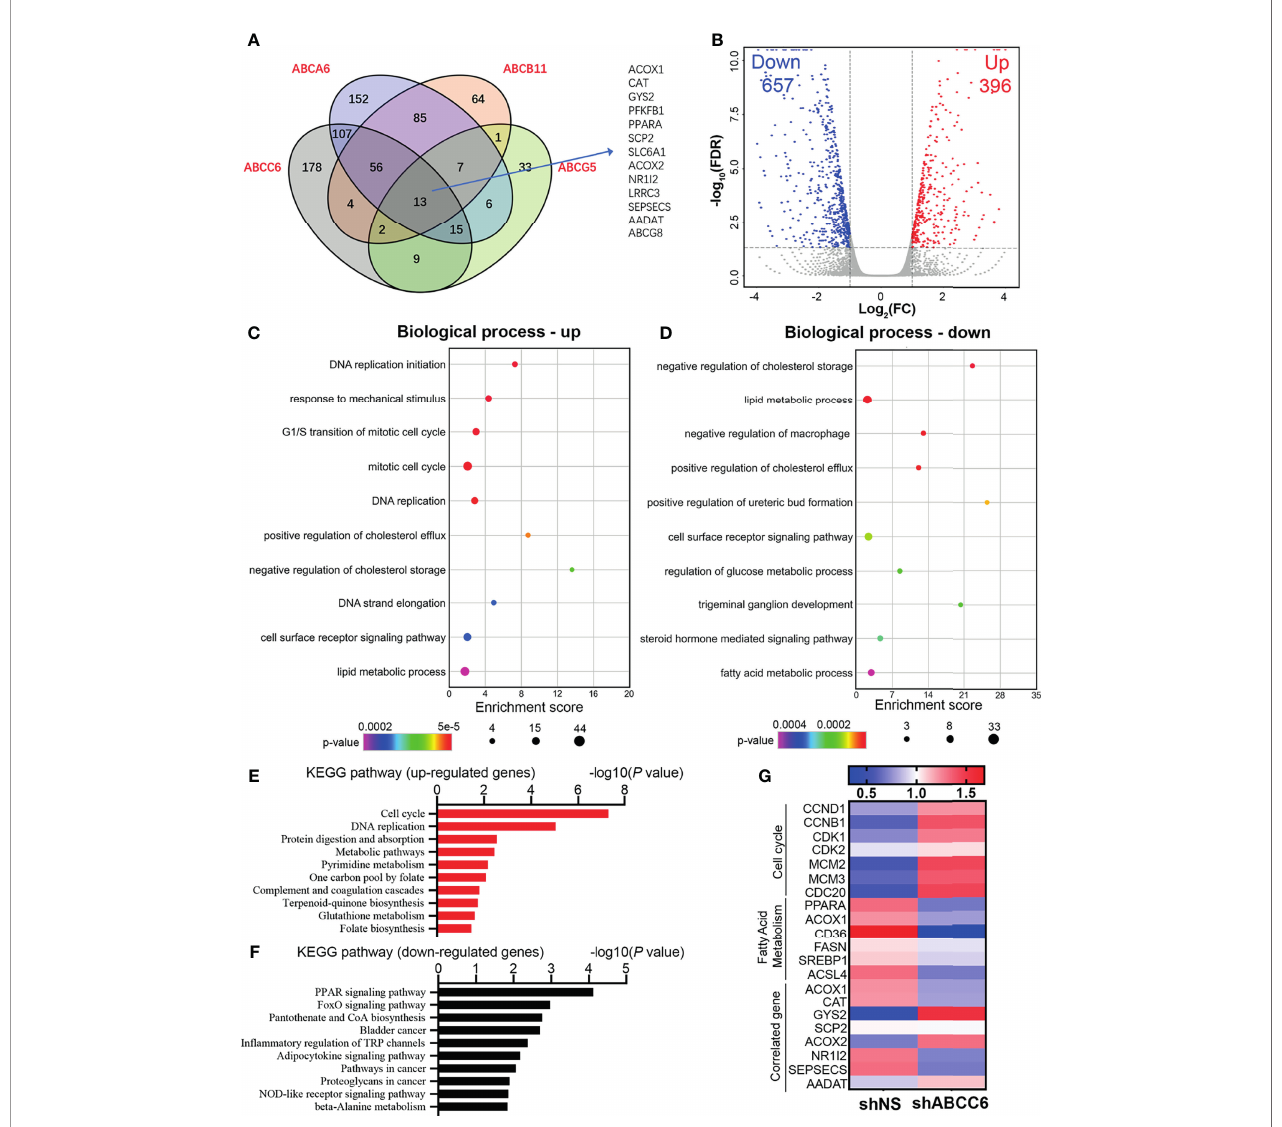
FIGURE 6 | Transcriptome-wide analysis of ABCC6 knockdown 97H cells. (A) Venn diagram showing the overlap among positive correlation (R>0.4) genes of ABCA6 , ABCB11 , ABCC6 and ABCG5 . Data was derived from TCGA database. (B) Volcano plot showing the up-regulated and down-regulated genes in ABCC6 knockdown 97H cells. Cut-off value: |log 2 (FC)|>1, P <0.05. (C) Gene Ontology (GO) enrichment analysis of up-regulated genes in ABCC6 knockdown 97H cells. (D) Gene Ontology (GO) enrichment analysis of down-regulated genes in ABCC6 knockdown 97H cells. (E) KEGG pathway analysis of up-regulated genes in